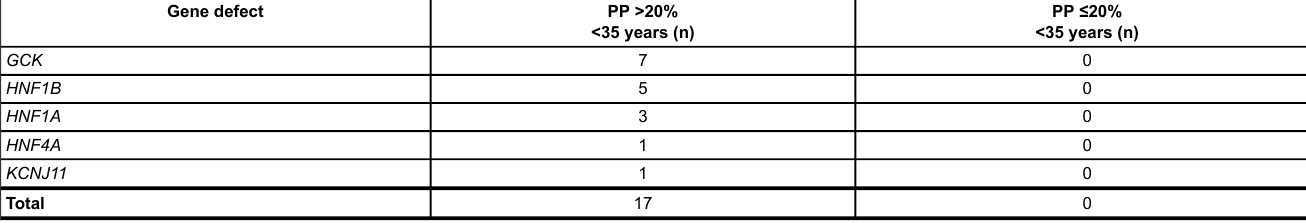
Table 3: Positive predictive values calculated by the MODY probability calculator in subjects with a genetic diagnosis of MODY. Gene